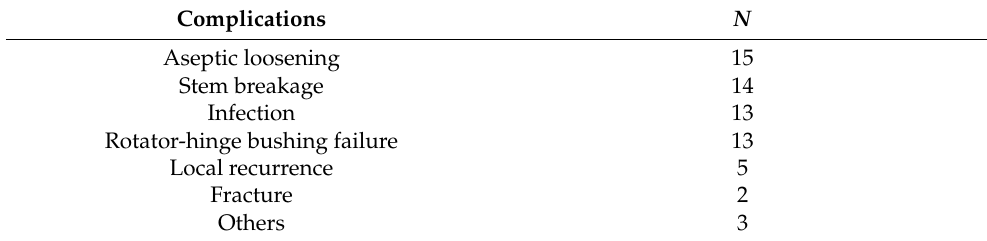
Table 2. Cause of implant failure.